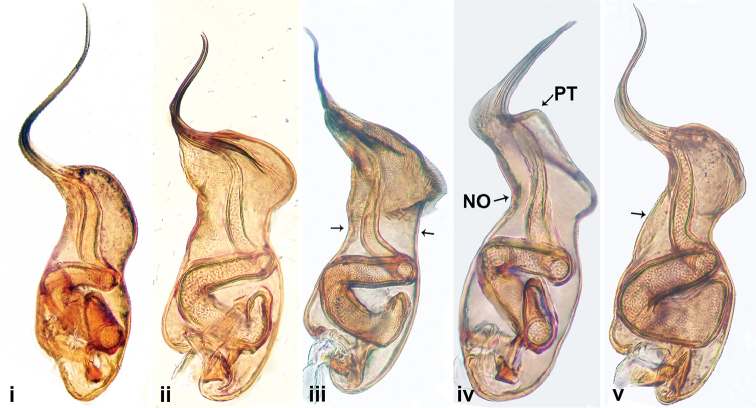
Prolateral view of male palp bulbs of Luzonacera species: iL.changiiL.duaniiiL.francescoballarini sp. n. ivL.lattuensis sp. n. and vL.peterjaegeri sp. n. Abbreviations: PT = protrusion, NO = notch.